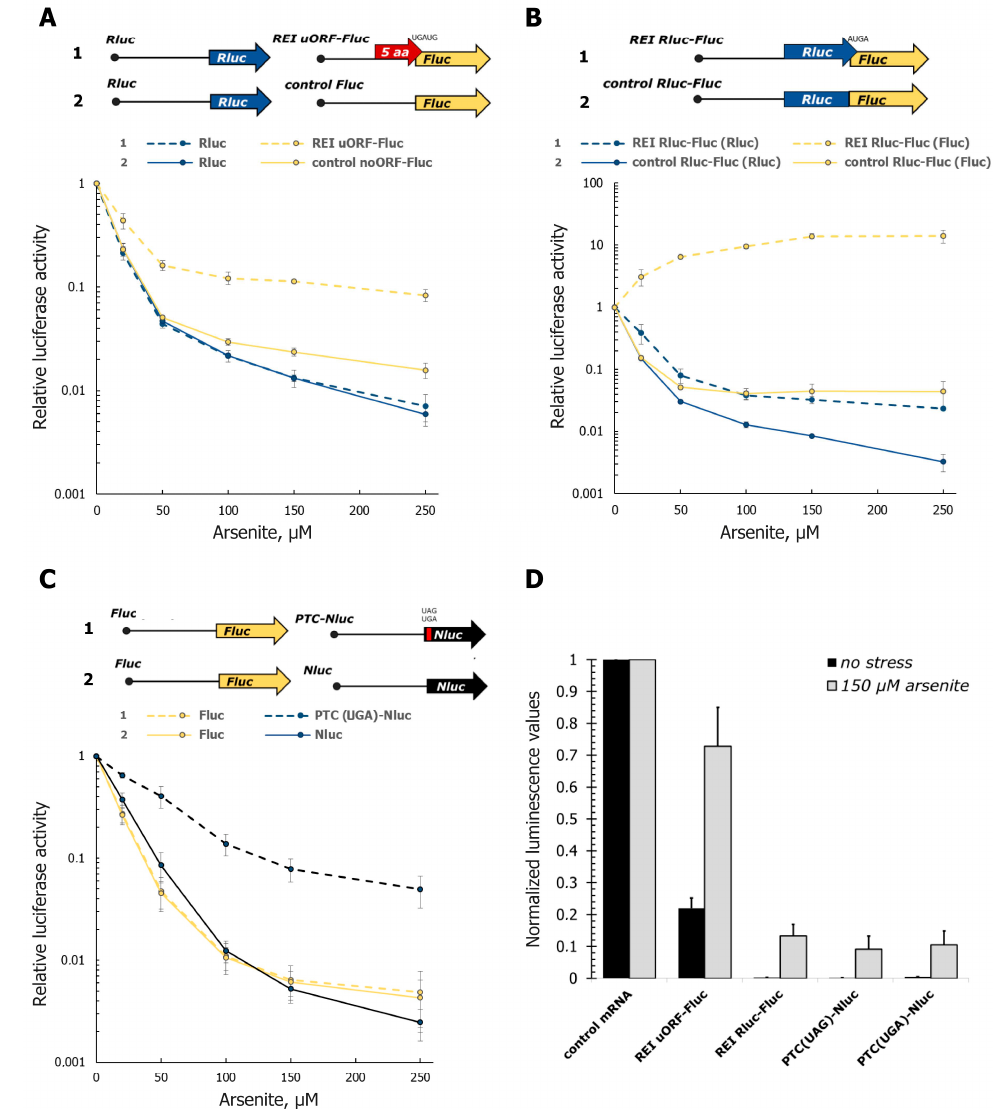
Figure 1. The rates of translation reinitiation and stop-codon readthrough are increased under conditions of arsenite-induced stress, as revealed by luciferase reporter assays. ( A – C ) Schematic representation of reporter mRNA constructs (upper panels) and relative luciferase activities in arsenite-treated HEK293T cells transfected with the constructs, normalized to that in untreated cells (lower panels). Reporter mRNAs have either a short uORF ( A ) or the full-length Rluc-encoding ORF ( B ) in front of Fluc CDS or harbor a PTC (premature termination codon) in the main ( Nluc ) CDS ( C ), as described in the text. In ( A ) and ( C ), transcripts encoding Rluc or Fluc, as indicated, were co-transfected as controls; 2 h after transfection, cells were lysed, and reporter-dependent luciferase activities were measured. ( D ) Translation efficiencies of the reporter mRNAs, divided into those of the corresponding control transcripts after normalization, in untreated or 150 µM arsenite-treated cells are shown (calculated from the same data as in (a-c)). The mean values (±SD) of at least three independent experiments are shown. The absolute values of luciferase units for untreated cells were ~9 × 10 5 for control Fluc , ~2 ×10 5 for REI uORF-Fluc , ~3 × 10 6 for Rluc , ~4 × 10 5 for control Rluc-Fluc (Fluc), ~3 × 10 3 for REI Rluc-Fluc (Fluc), ~1 × 10 7 for Nluc , ~4 × 10 4 for both PTC-Nluc mRNAs, ~8 × 10 5 for Fluc ; the background (no mRNA) values were 50 units for Fluc and 120 units for Rluc and Nluc.